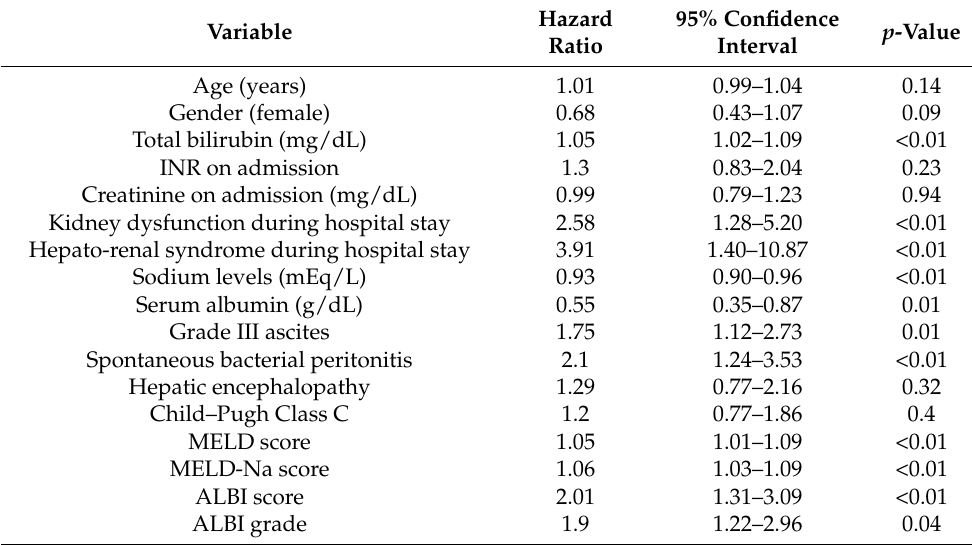
Table 4. Univariate Cox proportional hazards model in the hepatic hydrothorax group.